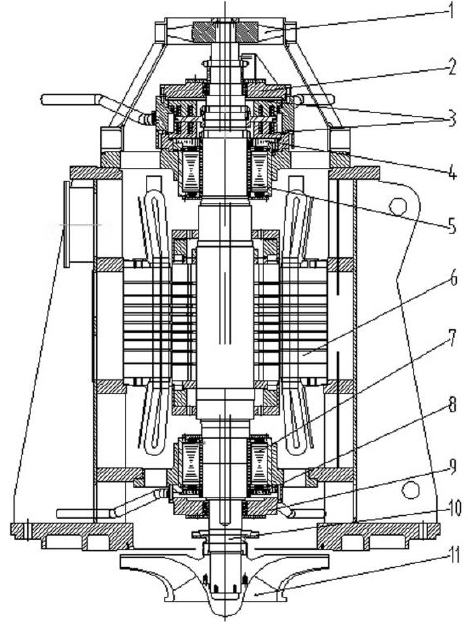
Figure 1. The structure of primary helium circulator (PHC) engineering prototype (PHC-EP) [12]. 1. Cooling fan; 2. upper auxiliary bearing; 3. axial thrust active magnetic bearing (AMB); 4. upper displacement sensor; 5. upper radial AMB; 6. asynchronous motor; 7. lower radial AMB; 8. lower displacement sensor; 9. lower auxiliary bearing; 10. rotor; 11.